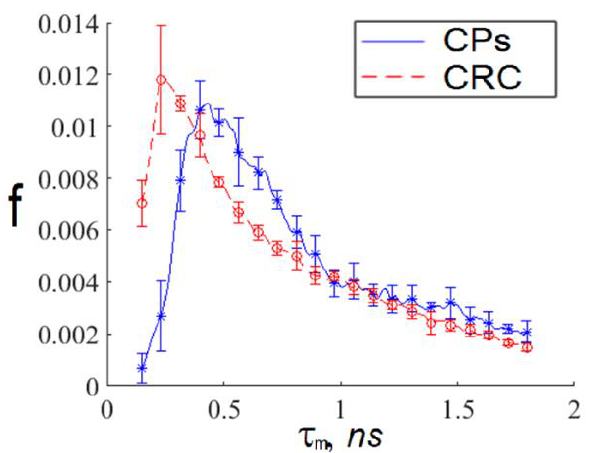
Figure 3. The average TPAF lifetime t m distributions, normalized on an area under the curve, for images of the exosome samples presented in Figure 2. Notations on the legend: CPs — the exosome sample from the randomly selected CRC patient; CRC — the exosome sample from the randomly selected CP patient. The t m distribution mean values and standard deviations were calculated by t m value-averaging over images presented in Figures 2a,b.